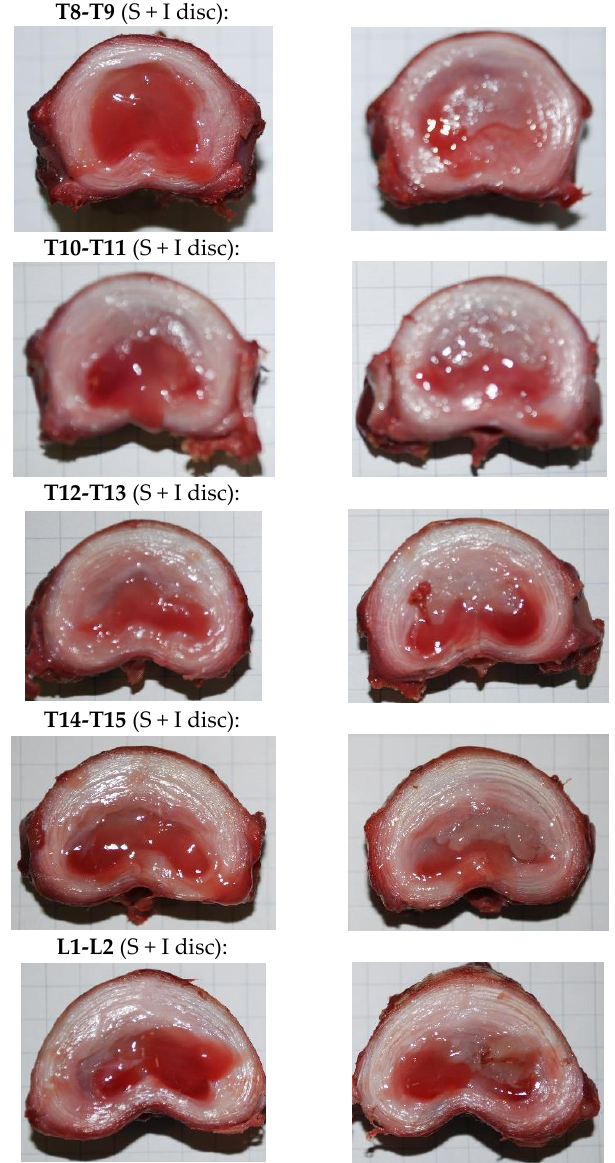
Figure 10. Each row shows the corresponding two transverse cut pieces produced from the dissection of different thoracic-lumbar discs of a pig model, after nucleosupplementation with injection of CNF/CHI formulation (2% ( w / w ) CHI/ 0.3% ( w / w ) CNFs). After injection and before discal dissection, the